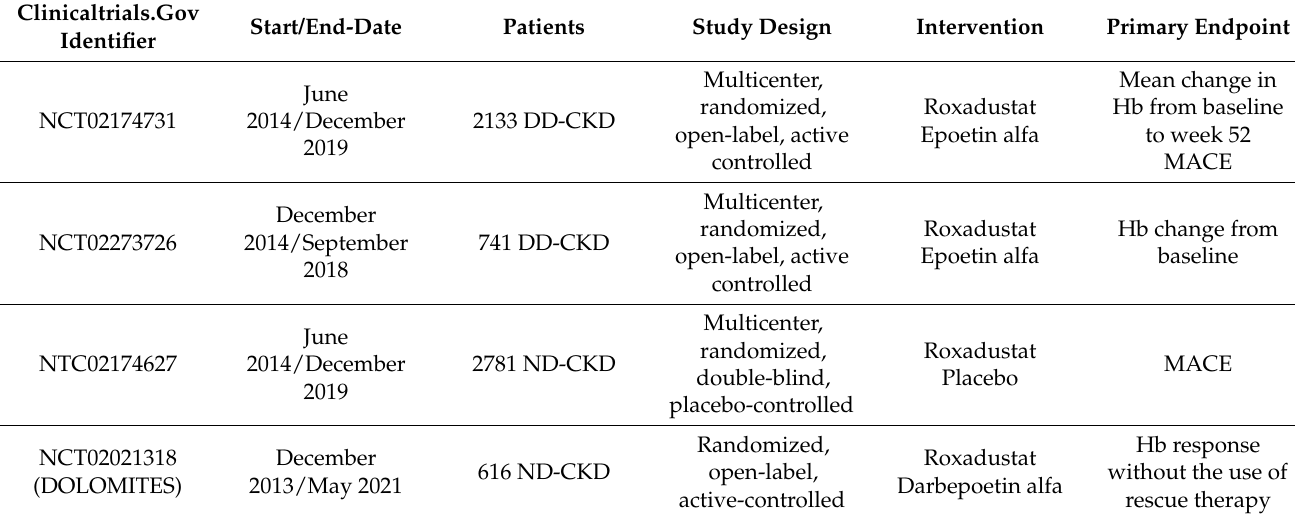
Table 2. Phase 3 clinical trials of